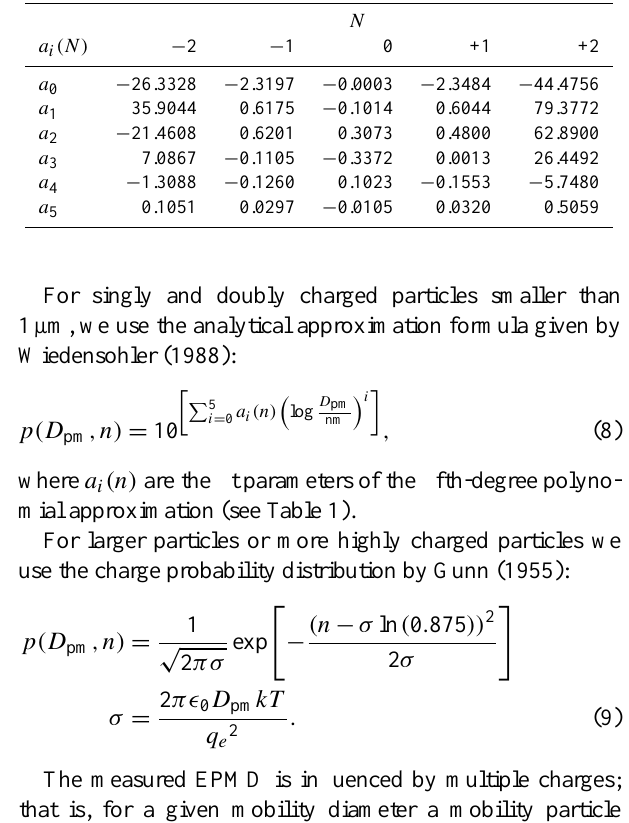
Table 1. Fit parameter for specific charge of the fifth-degree poly- nomial approximation of Wiedensohler